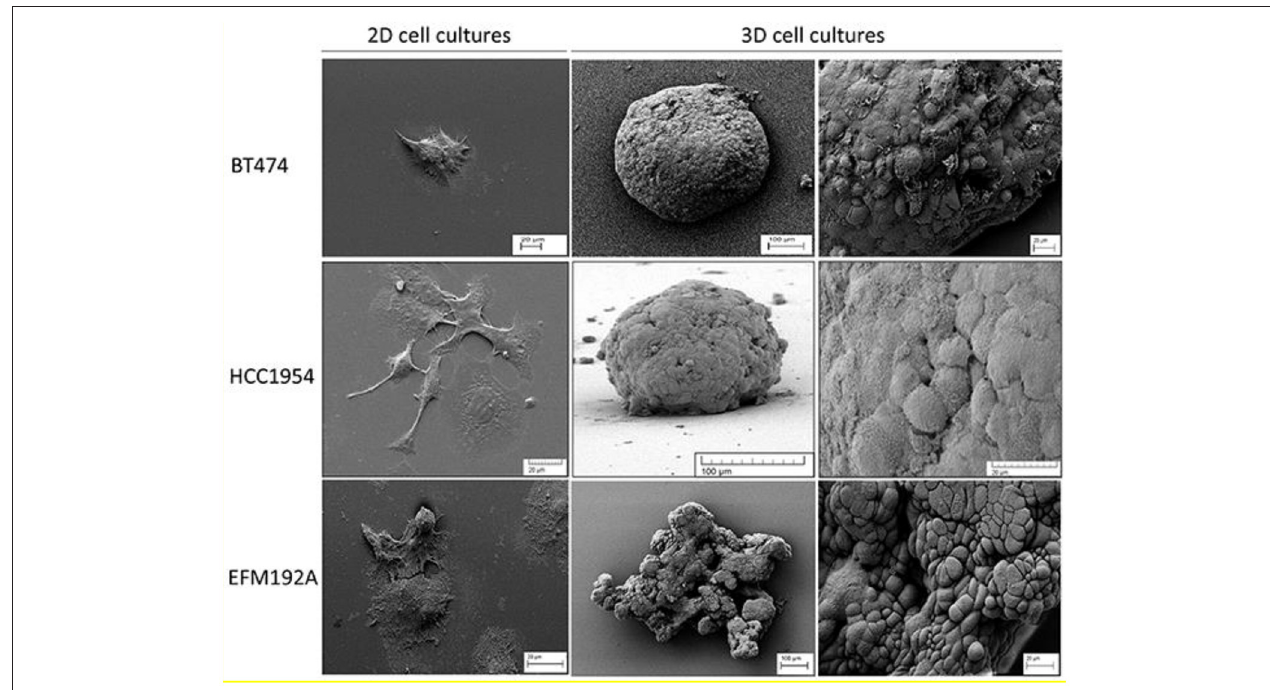
FIGURE 1 | SEM (scanning electron microscope) images of 2D and 3D cell cultures that illustrate the difference in cell morphology for three different breast cancer lines. Both BT474 and HCC1954 cells form tightly packed spheroids when grown in 3D, while EFM192A cells form a less organized 3D structure under the same conditions. Scale bars are shown on the images. This figure is reprinted under the terms of the Creative Commons Attribution License from Breslin and O’Driscoll (2016)